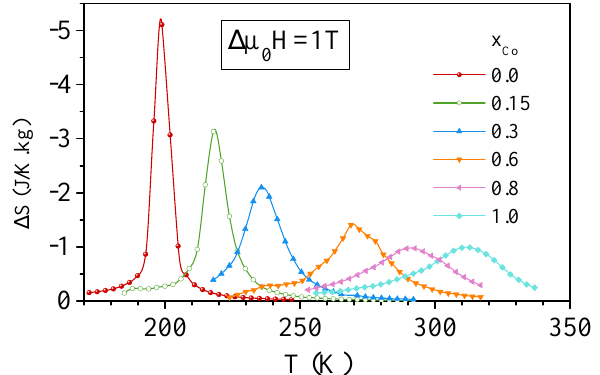
Figure 5. Magnetic ∆ S M variations for different x Co content for LaFe 11.5 − x Co x Si 1.5 [52]. The 57 Fe Mössbauer spectra that were collected at room temperature, for x = 0.8, 1,